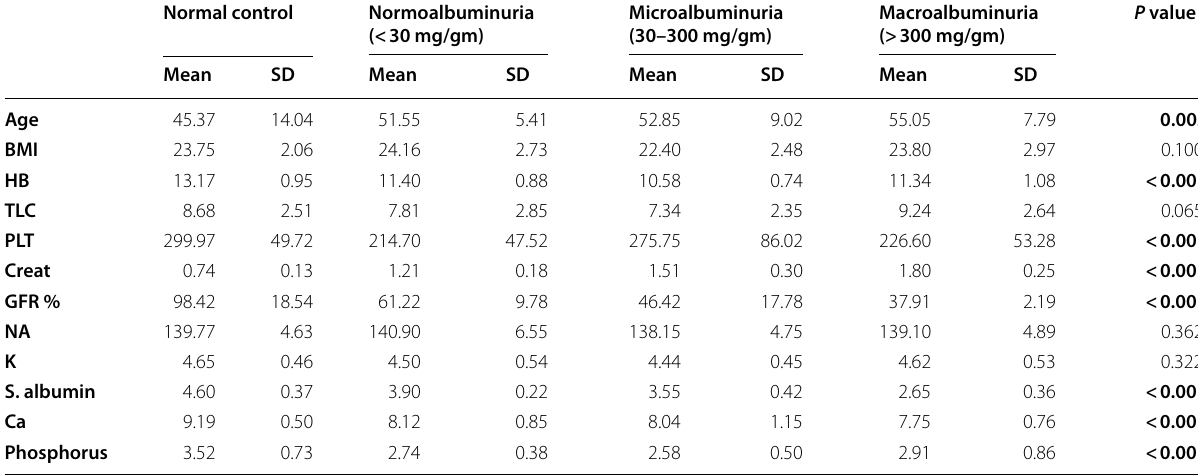
Table 3 Comparison among four groups as regards basic laboratory data Normal control